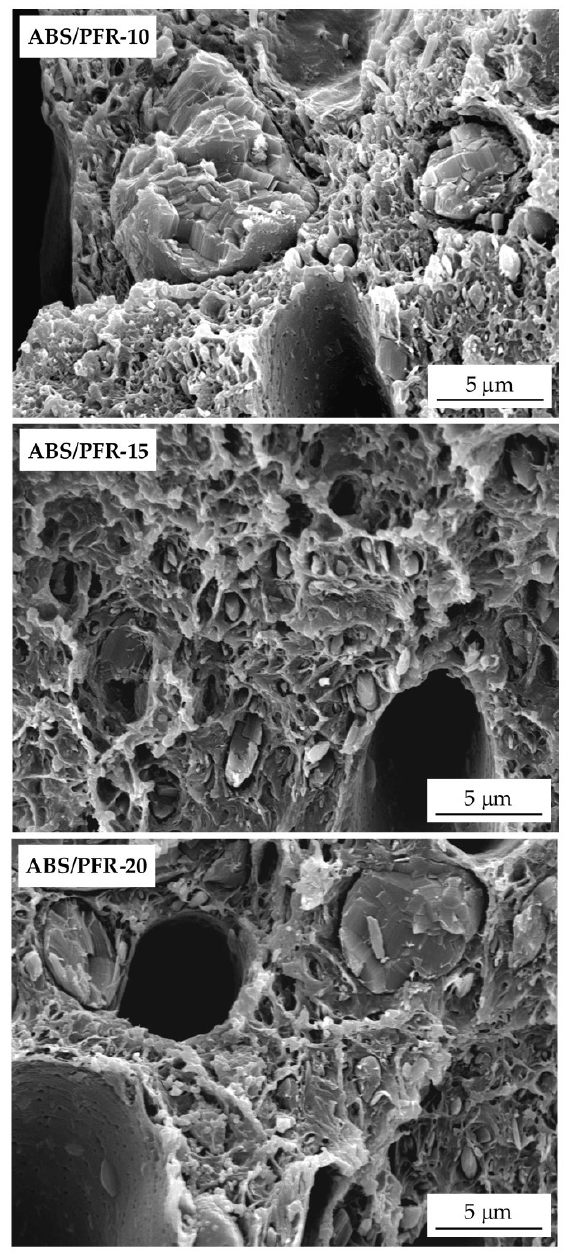
Figure 4. SEM images showing PFR particles throughout the cell walls of ABS/PFR